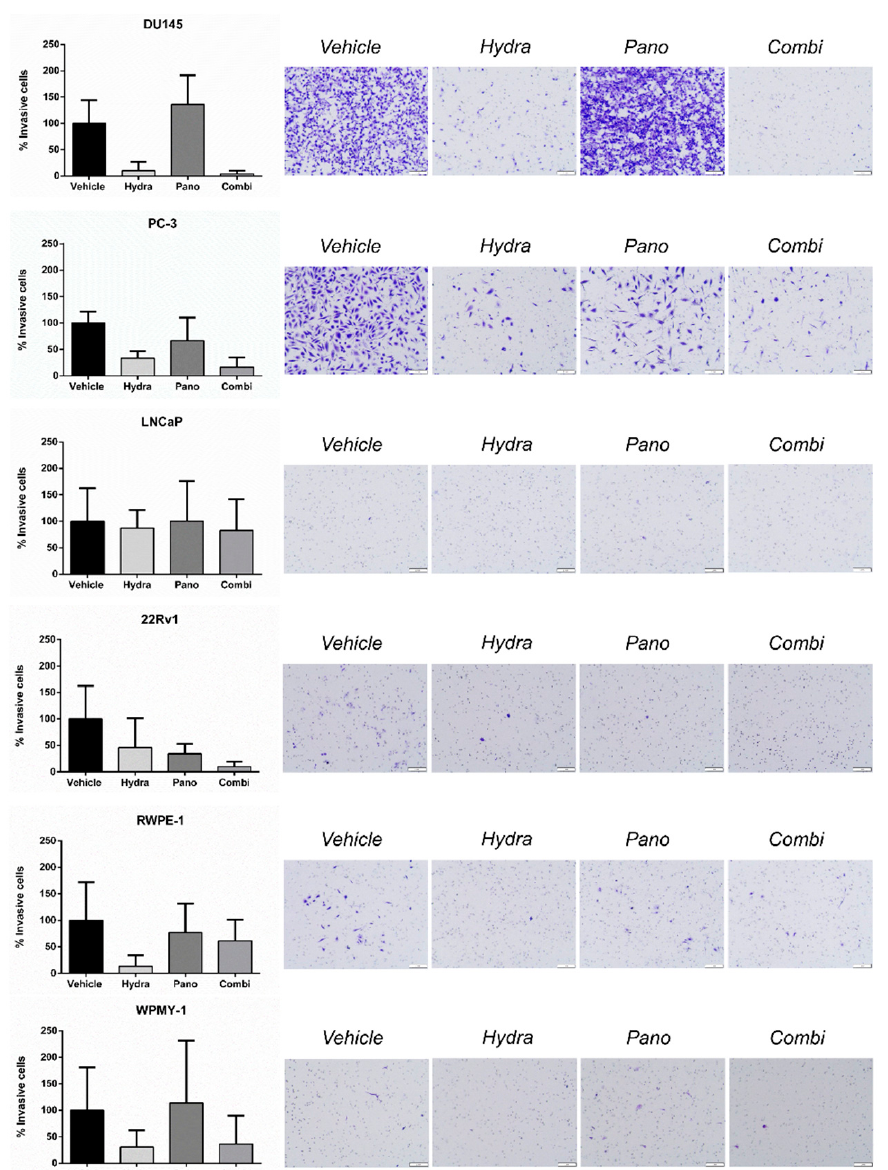
Figure 6. Effects of hydralazine and panobinostat exposure in prostate cell lines migration potential. Cell lines were seeded in migration invasion transwell inserts upon epidrug exposure for 24 h. The percentage of invasive and migratory cells was determined by dividing the mean counted cells by the area of the microscope viewing field and then multiplying by the entire area of the insert. The results are representative of three biological replicates ( n = 3). Mean values ± SD are shown ( left panel ). Representative images of invasive and migratory cells stained with Crystal Violet are displayed ( right panel ). The inserts were photographed with stereomicroscope Olympus S2X16 using a digital camera Olympus SC180 (scale bar 1 mm) at 115 × magnification. Drug concentrations: DU145–Hydra: 50 µ M, Pano: 5 nM; PC-3, RWPE-1 and WPMY-1–Hydra: 100 µ M, Pano: 10